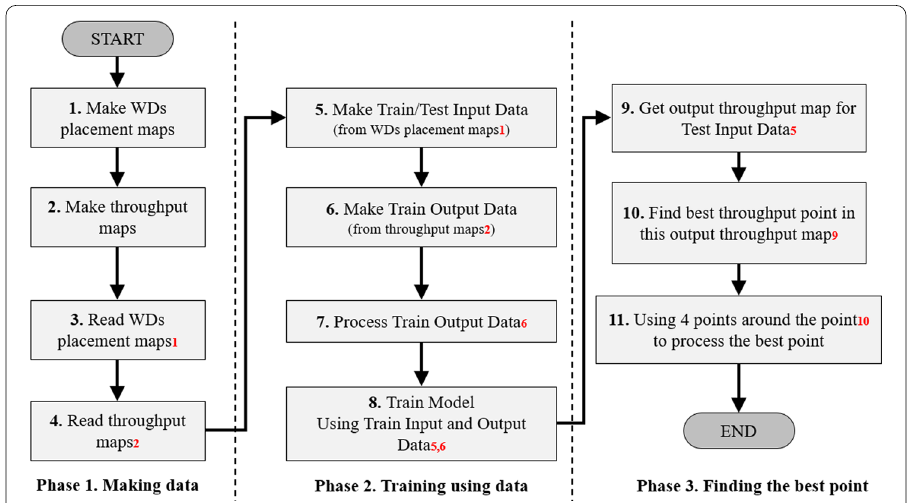
Fig. 2 Flow chart of HAP placement model. Note that the number after the description of each phase means the order of the stage whose data are used in this